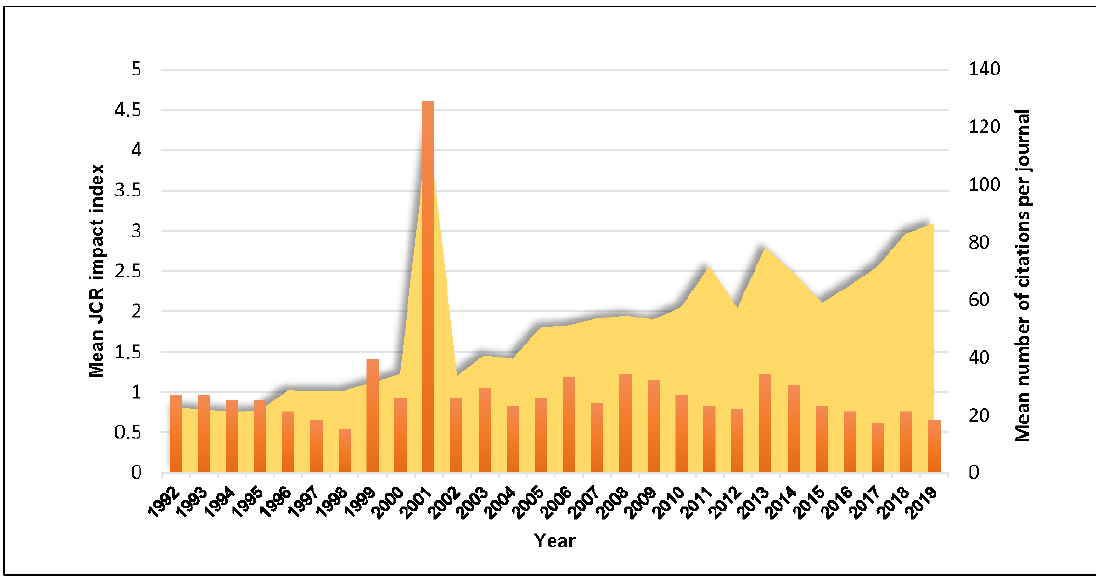
Figure 3. Mean JCR impact index and mean number of citations per year between 1992 and 2019.